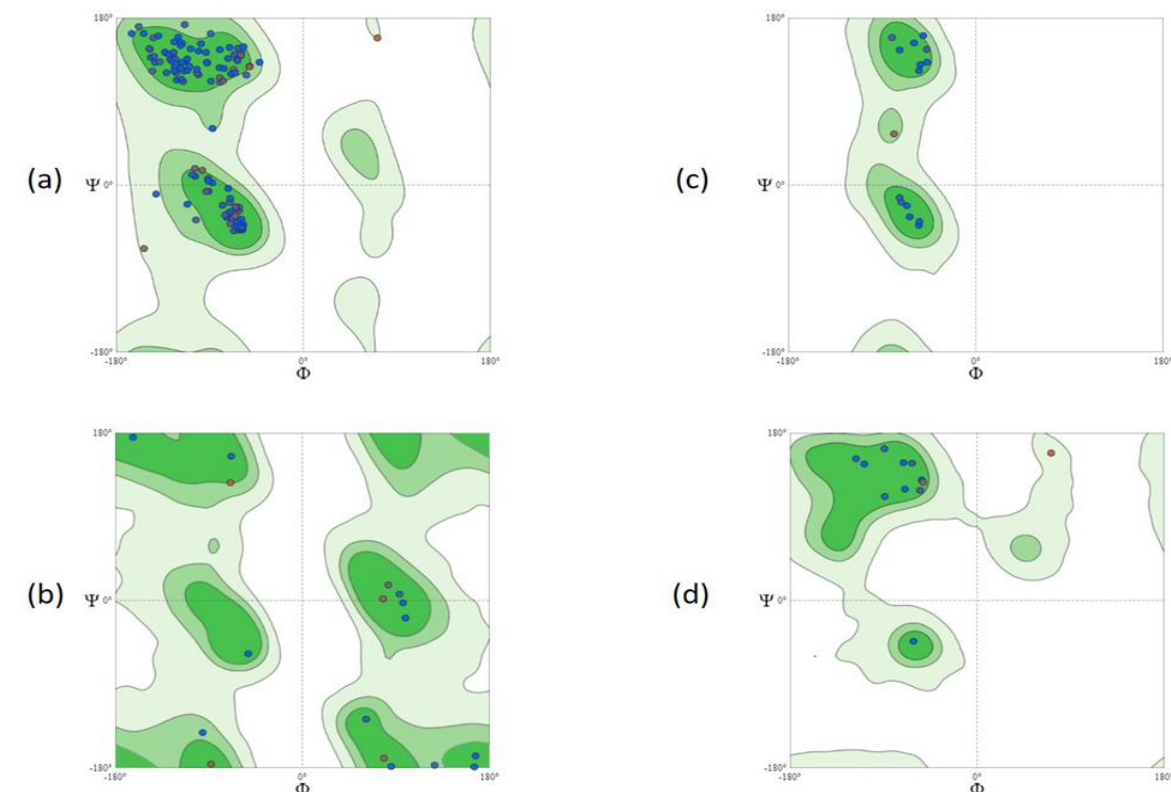
Fig. 3. The Ramachandran plot assessment (a) General, (b) Glycine, (c) Proline, and (d)